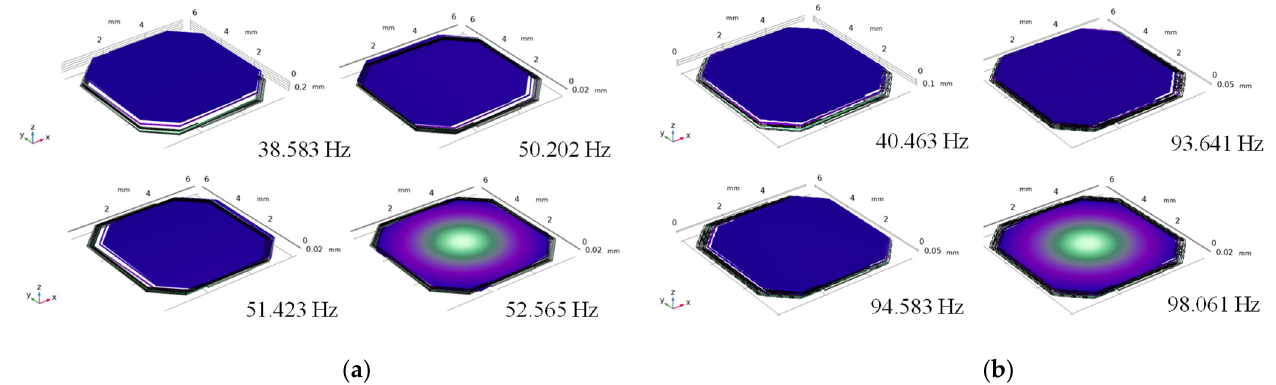
Figure 9. ( a ) Modal simulation results of normal beams; ( b ) modal simulation results of hollow beams.